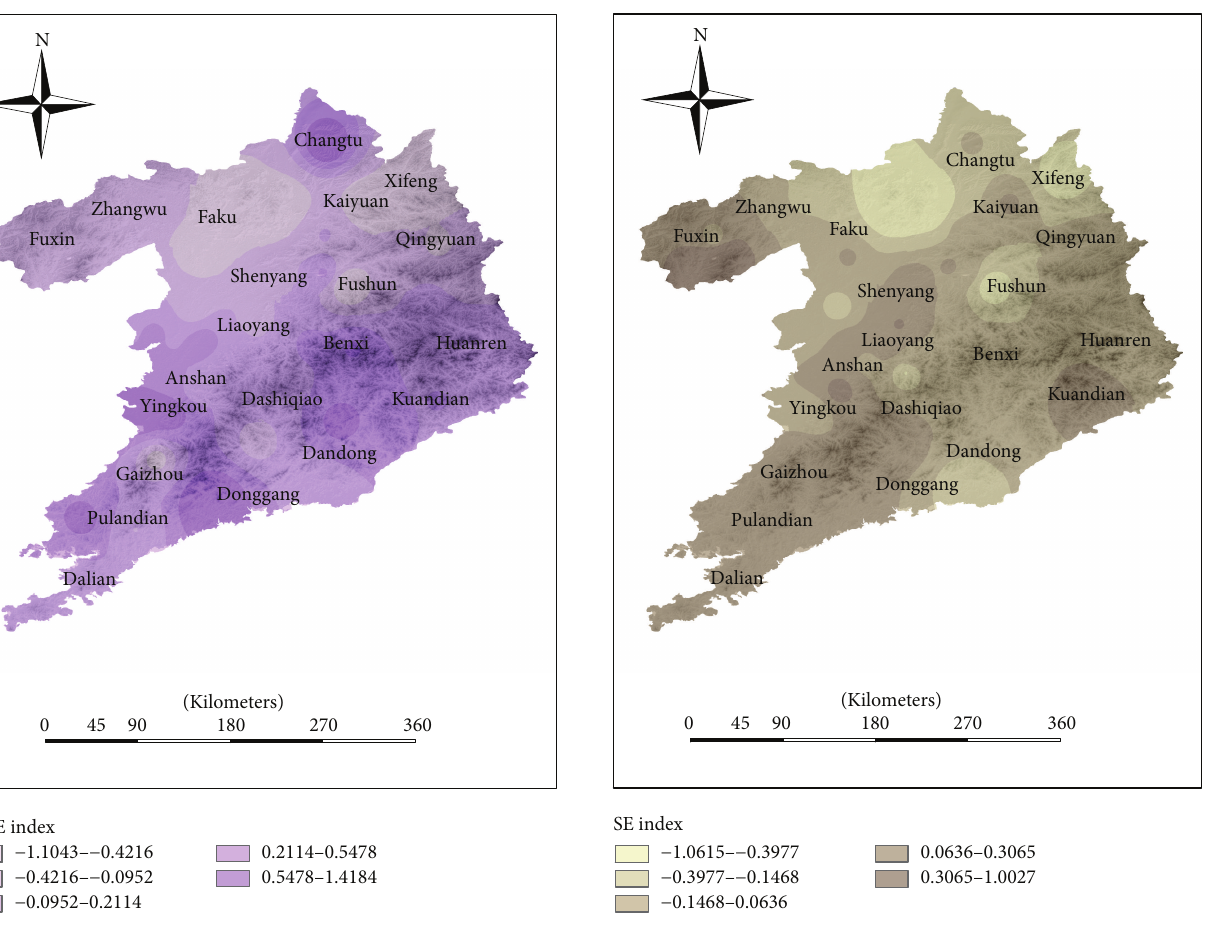
with the backwardness of economic development, the HLEE indexes in these counties are much lower than other counties.